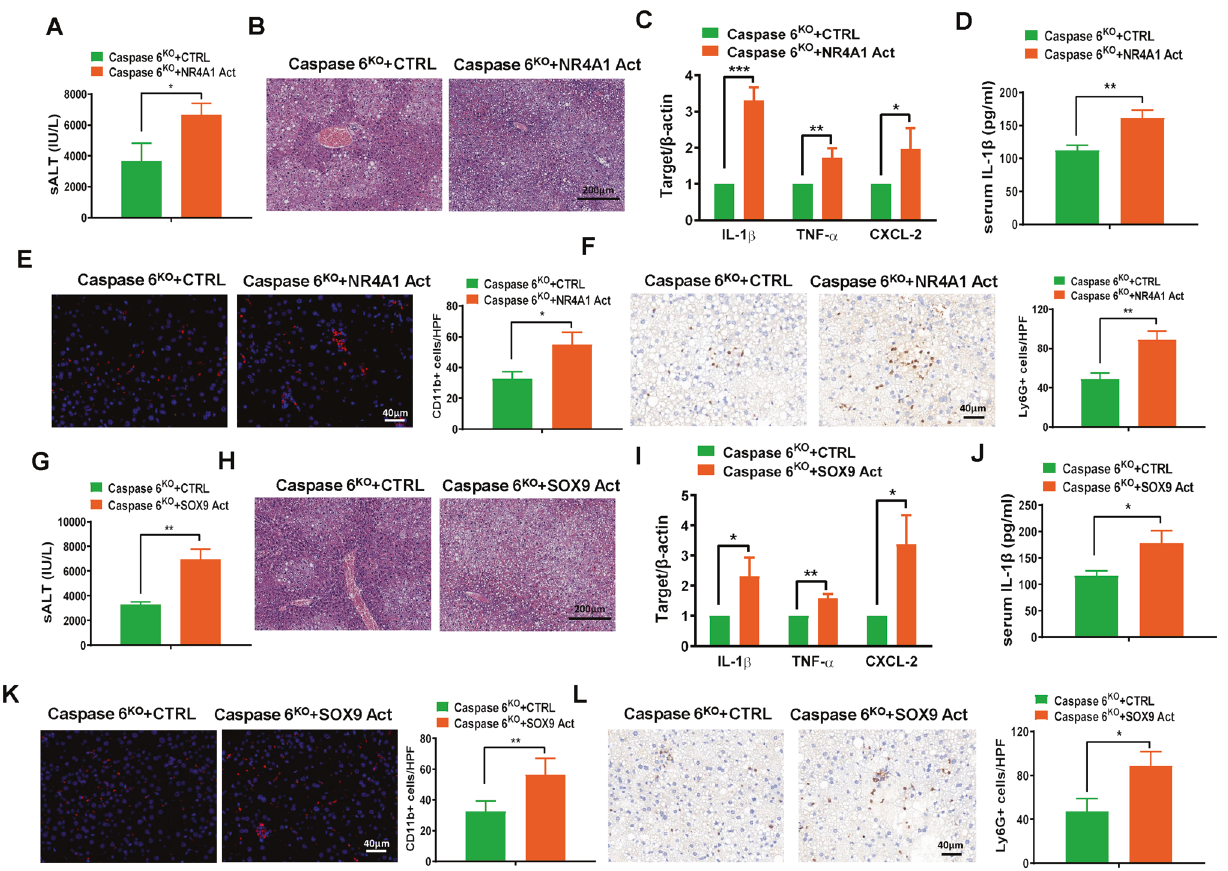
Fig. 4 NR4A1/SOX9 signaling controls proin fl ammatory responses in IR-stressed fatty liver. NR4A1 or SOX9 activation (Act) plasmids or control (CTRL) vectors mixed with mannose-conjugated polymers were injected into Caspase 6 KO mice 24 h before establishing HIR models. A , G Serum ALT levels in ischemic fatty livers; ( B , H ) H&E staining of ischemic fatty livers, Scale bar: 200 μ m; ( C , I ) Detection of cytokines IL-1 β , TNF- α and CXCL-2 by qRT-PCR in ischemic fatty livers; ( D , J ) ELISA analysis of serum IL-1 β levels; ( E , K ) IF staining and quanti fi cation of CD11b + macrophages in ischemic fatty livers, Scale bar: 40 μ m; ( F , L ) IHC staining and quanti fi cation of Ly6G + neutrophils in ischemic fatty livers, Scale bar: 40 μ m; N = 4 – 7/group, all data represent the mean ± SD, * p < 0.05, ** p < 0.01, *** p <